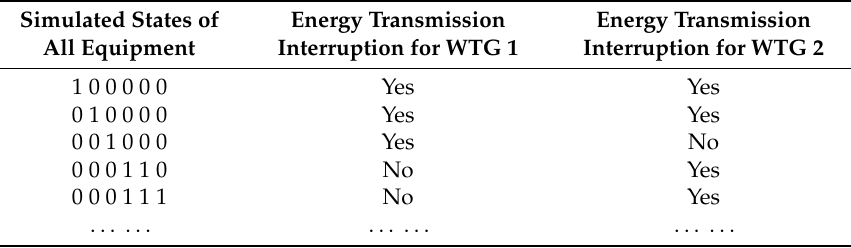
Table 1. An example for describing the proposed technique.